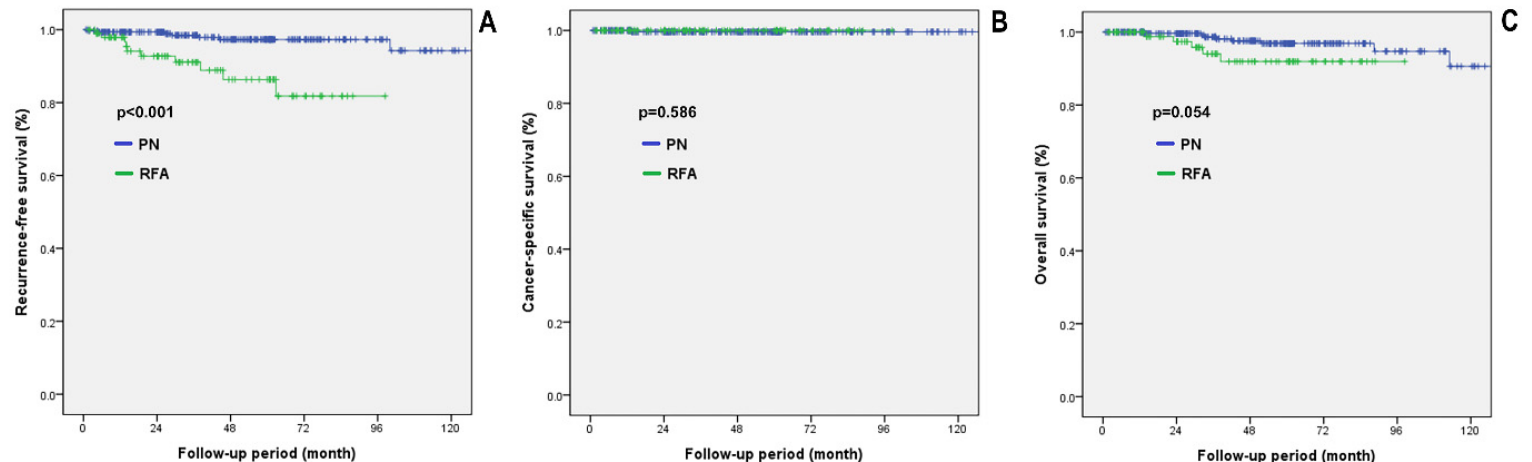
Figure 1. Survival analysis in all patients with cT1a tissue-proven malignancy. ( A ) RFS, recurrence-free survival; ( B ) CSS, cancer-specific survival; ( C ) OS, overall survival. PN: partial nephrectomy; RFA: radiofrequency ablation.